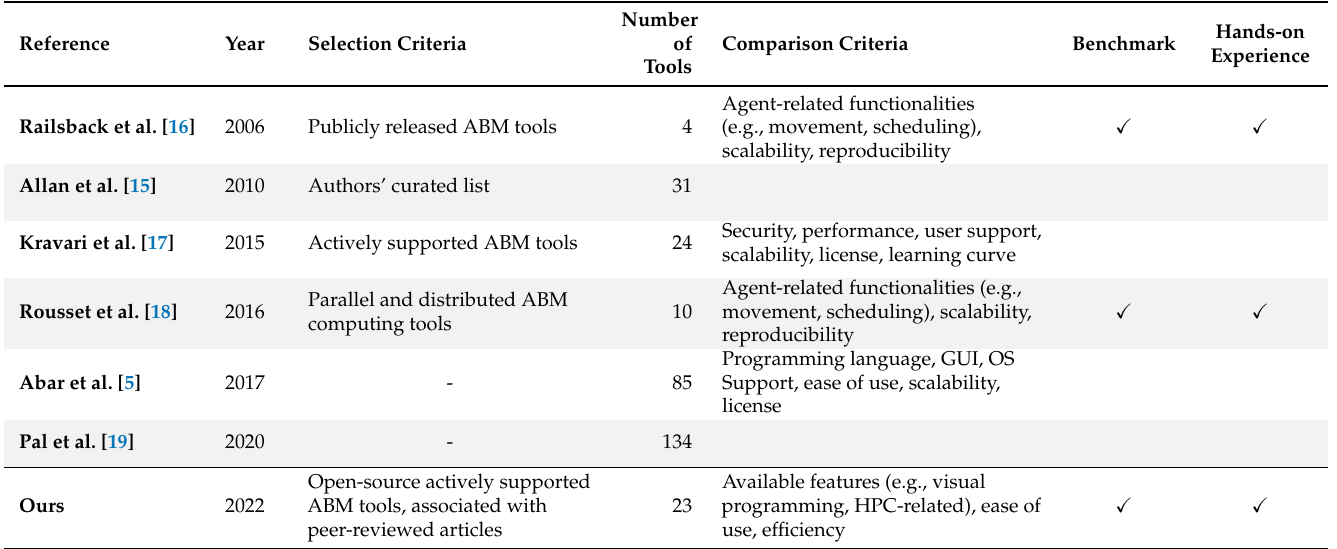
Table 1. Comparison of the existing ABMs reviews. The symbol "-" means that the authors did not explicitly state any constraints on the ABM tools considered in their